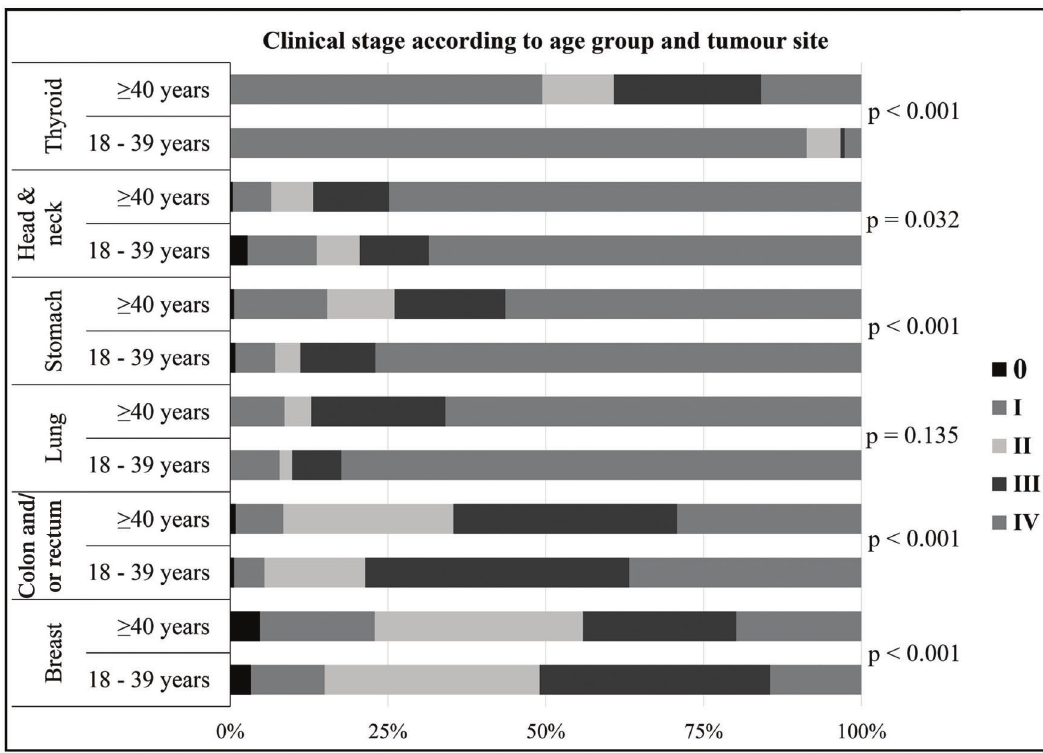
Figure 4 - Clinical stage according to age and tumor